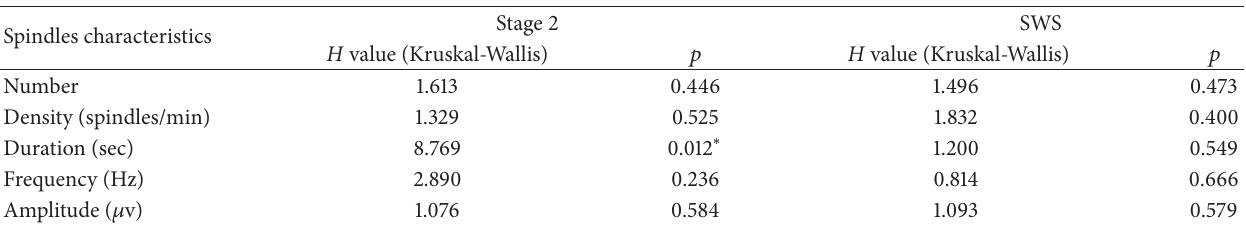
Table4:Differencebetweengoodsleepers,paradoxicalandpsychophysiologicalinsomniasufferersaccordingtosleepspindlescharacteristics on night